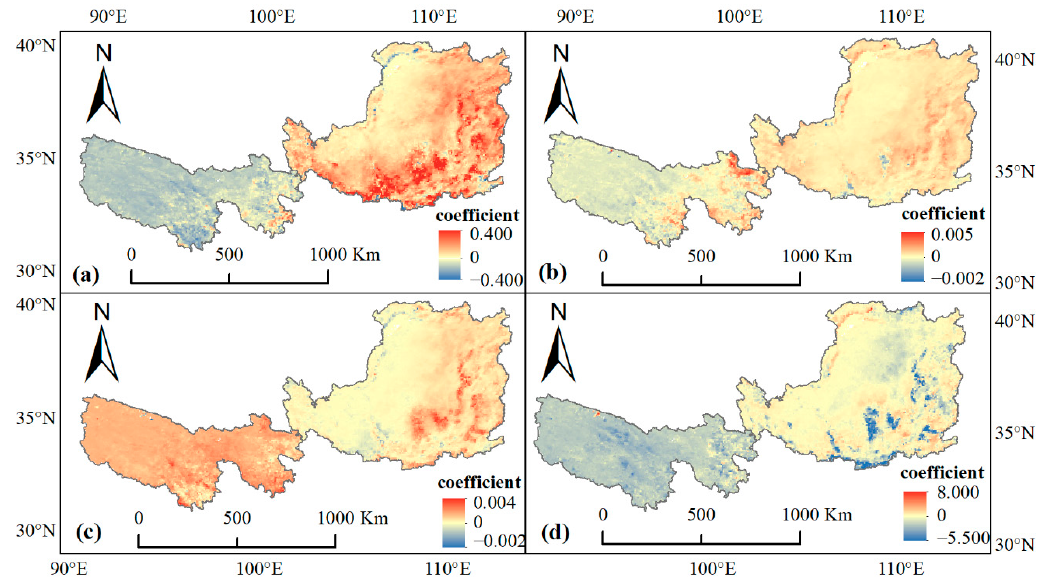
Figure 8. Spatial patterns of the relative contribution of human activities to vegetation greening ( p < 0.05) during the three periods: 1982–2019 ( a ), before the implementation of ecological engineering ( b ), and after the implementation of ecological engineering ( c ). Nevertheless, the relative contribution of climate variabilities and human activities shifted considerably between the two time periods, divided by the initiation of the eco- logical engineering projects. Before implementing the projects, climate variabilities con- trolled 81.52% of vegetation greening area on the LP, and the positive effect of human